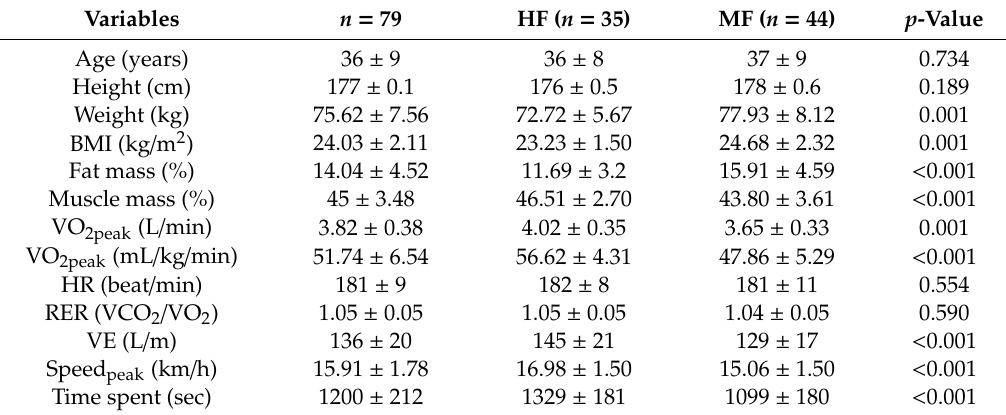
Table 1. General characteristics of whole sample and of the two study groups.